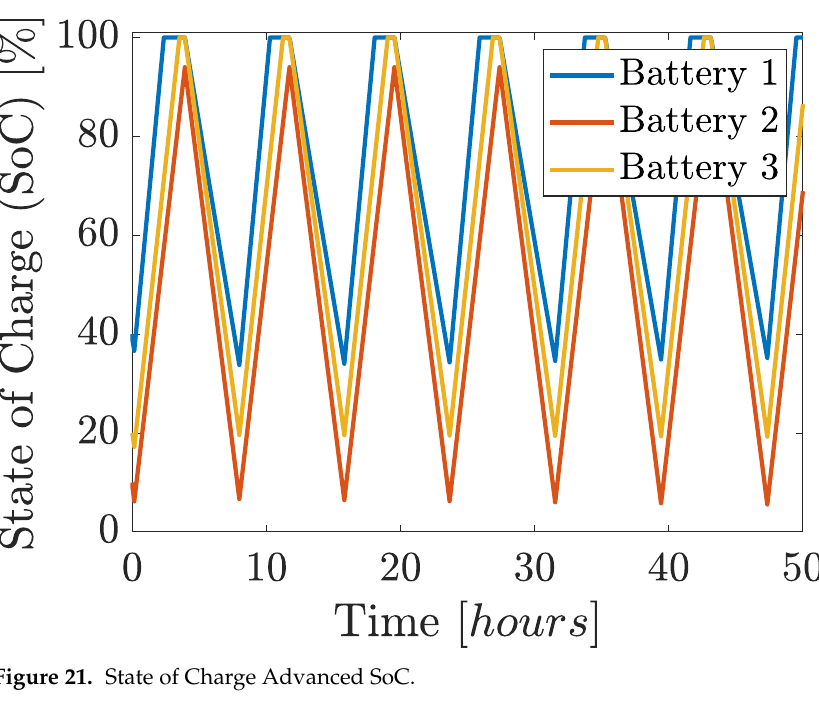
Figure 21. State of Charge Advanced SoC.